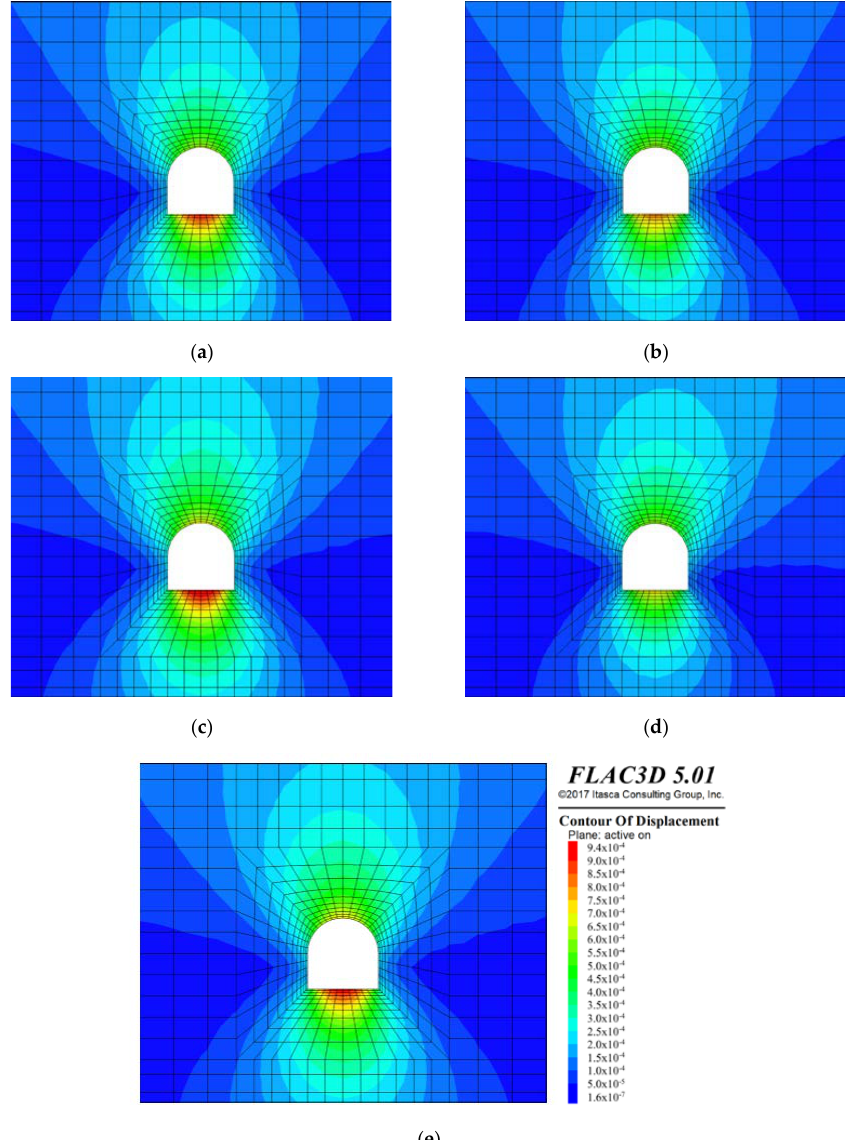
Figure 12. XZ plane at y = 0 with the contour of displacement (colour scale in m) of the rock mass after the excavation for: ( a ) model 1; ( b ) model 2-cluster 1; ( c ) model 2-cluster 2; ( d ) model 2-cluster 3; and ( e ) model 2-cluster 4.